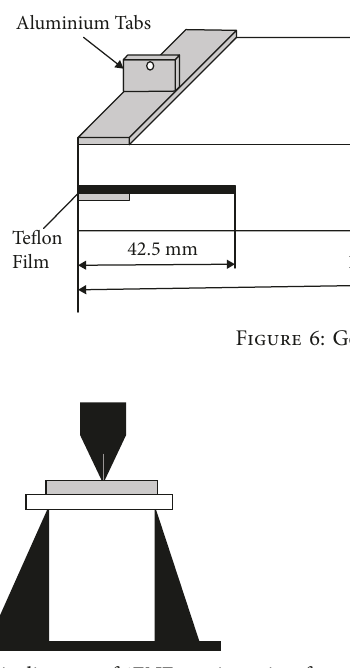
Figure 7: The schematic diagram of 4ENF specimen in a four-point bend mode.